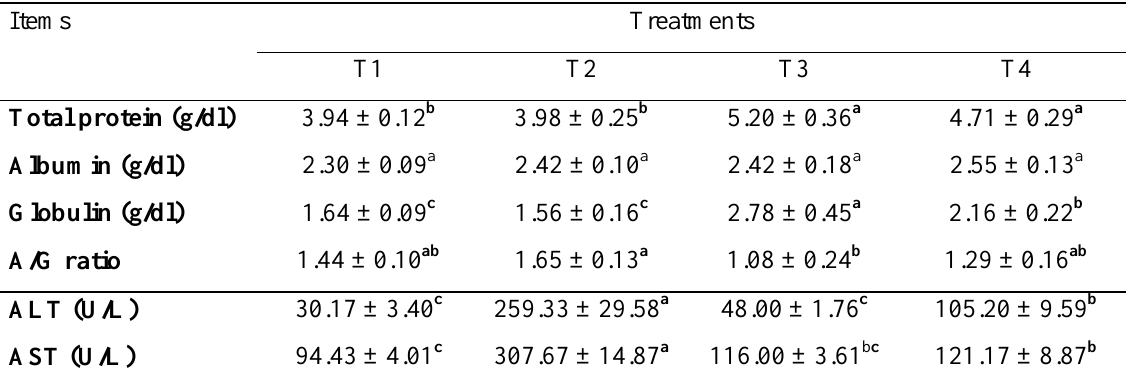
Table 5: The impact of aqueous extract of Eruca sativa leaves on biochemical parameters of healthy and thioacetamide intoxicated mice (Mean ±